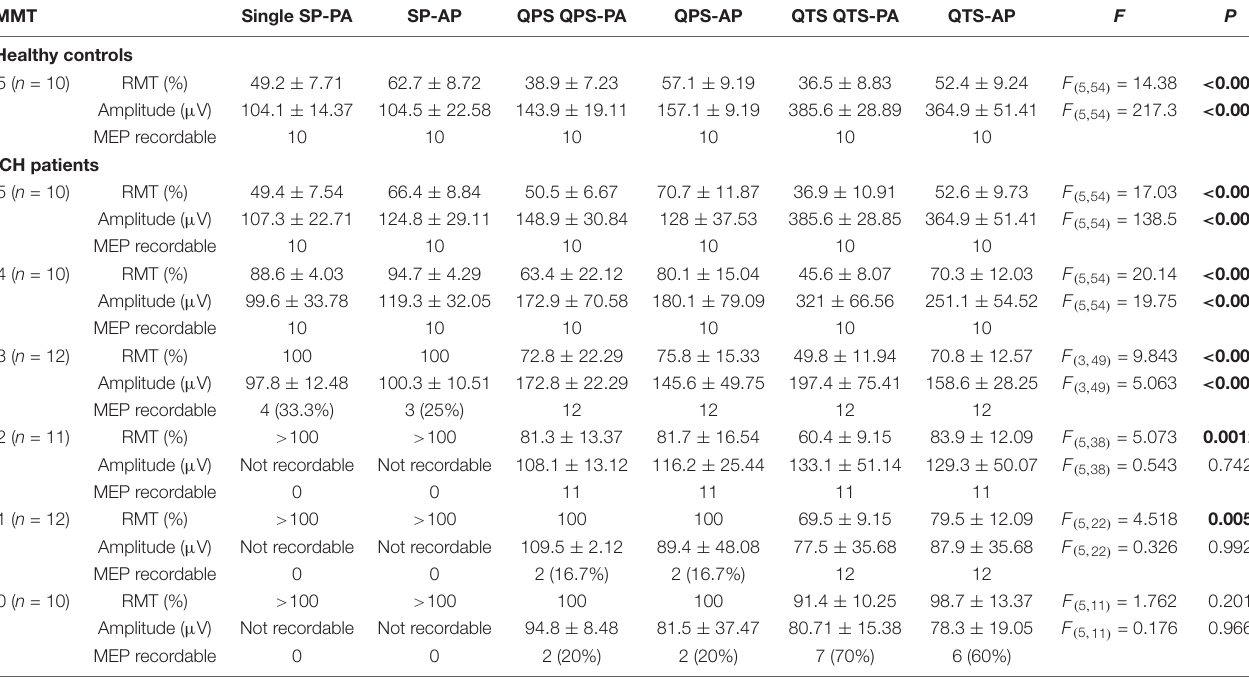
TABLE 1 | Quantitative differences in the motor evoked potential (MEP) parameters between six stimulus conditions. MMT Single SP-PA SP-AP QPS QPS-PA